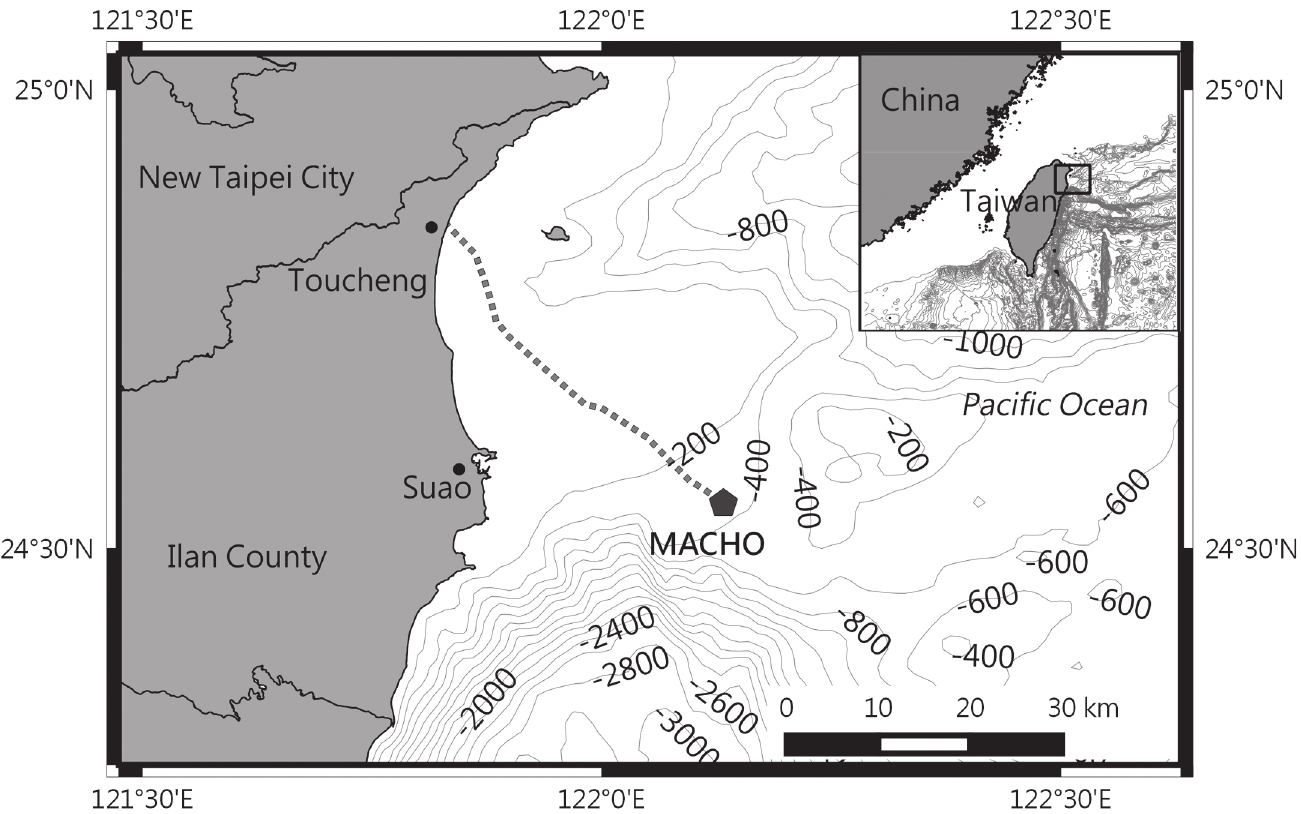
Fig 1. Location of the marine cable hosted observatory. The MACHO is connected with a land station at Toucheng Town through a 45-km-long submarine cable (dashed